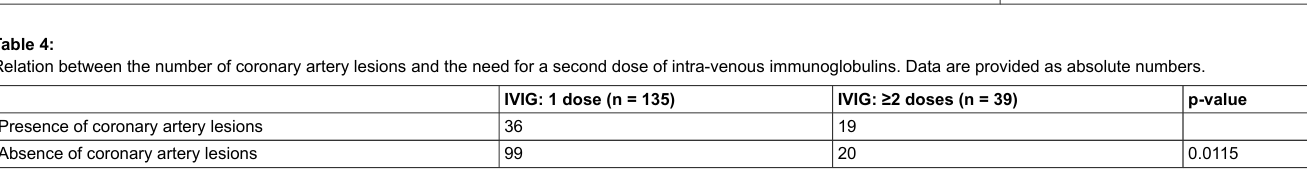
Table 5: Presentation characteristics among children younger versus older than 5 years. Continuous variables are expressed as mean [range]. Categorical variables are expressed in ab- solute numbers (%).